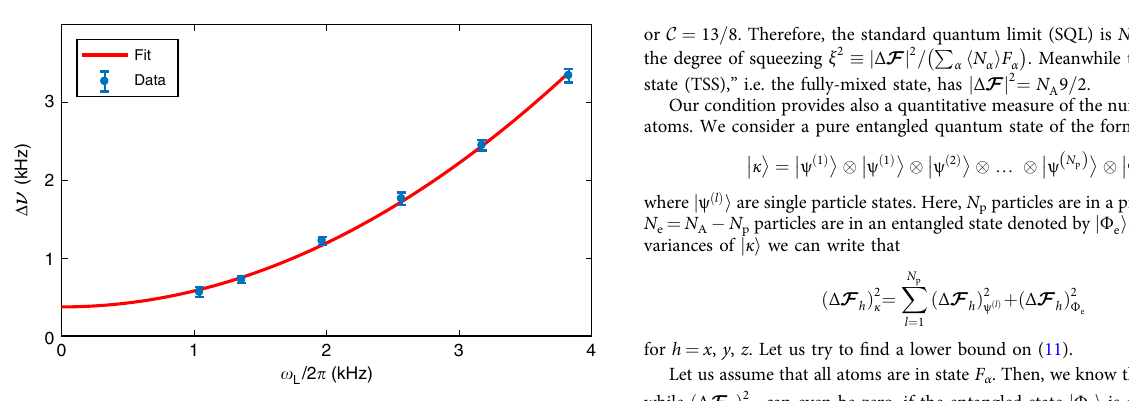
Fig. 4 Density calibration by spin noise spectroscopy. Graph shows the full-width at half maximum linewidth Δ ν as a function of ω L , across the transition into the spin-exchange relaxation free (SERF) regime. Blue dots and error bars show the mean ±1 σ standard error of the mean, obtained from the fi tting of 20 spectra. Red line shows Eq. (4) fi t to the data with density n Rb as a free parameter. Probe power = 1 mW, T =